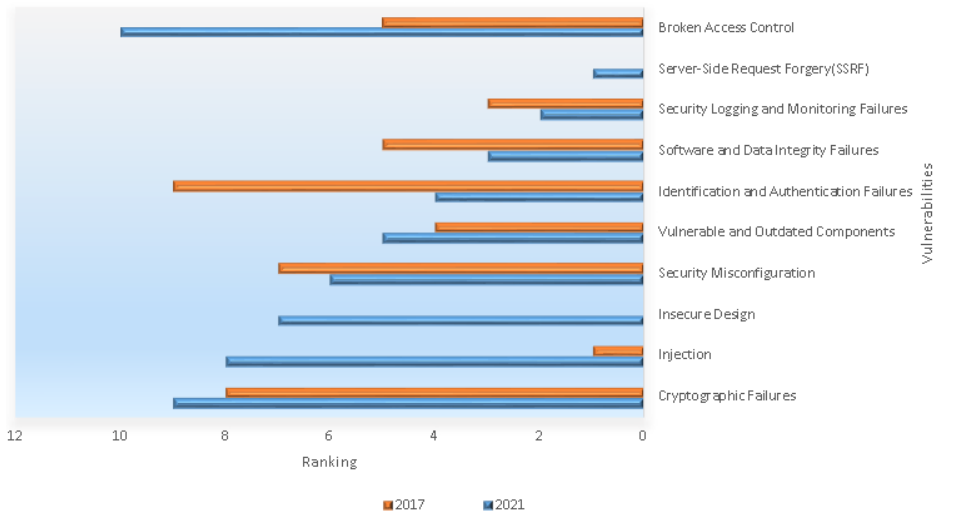
Figure 6. Updated list of top 10 web application security risks for 2021 compared to their ranking in 2017, collected from (OWASP)